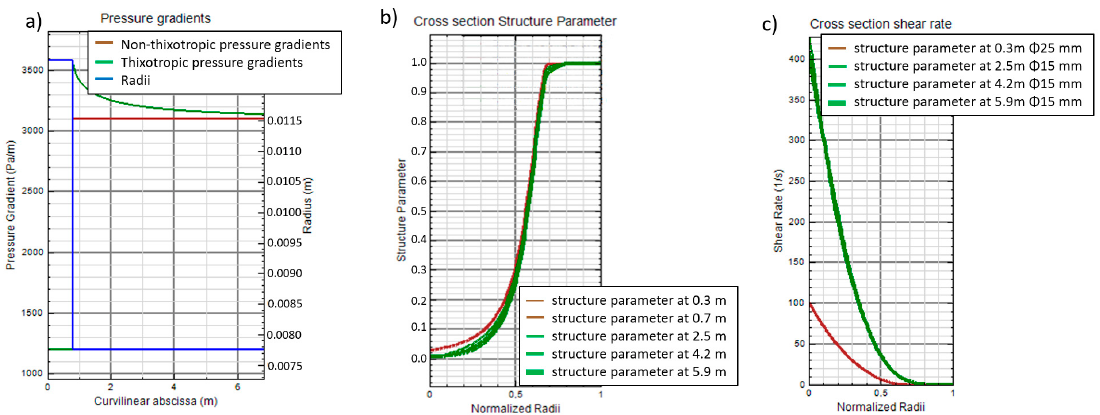
Figure 20. ( a ) Pressure gradients along the flow loop for non-thixotropic and thixotropic fluids having the same steady state rheological behavior, ( b ) structure parameter in various cross-sections along the flow-loop, ( c ) shear rate in various cross-sections along the flow-loop.